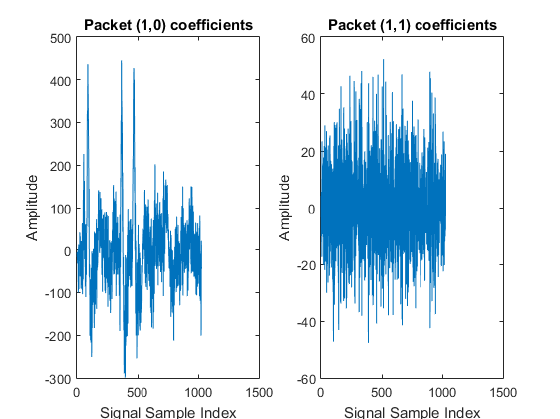
Fig. 6. 1st level decomposition coefficients